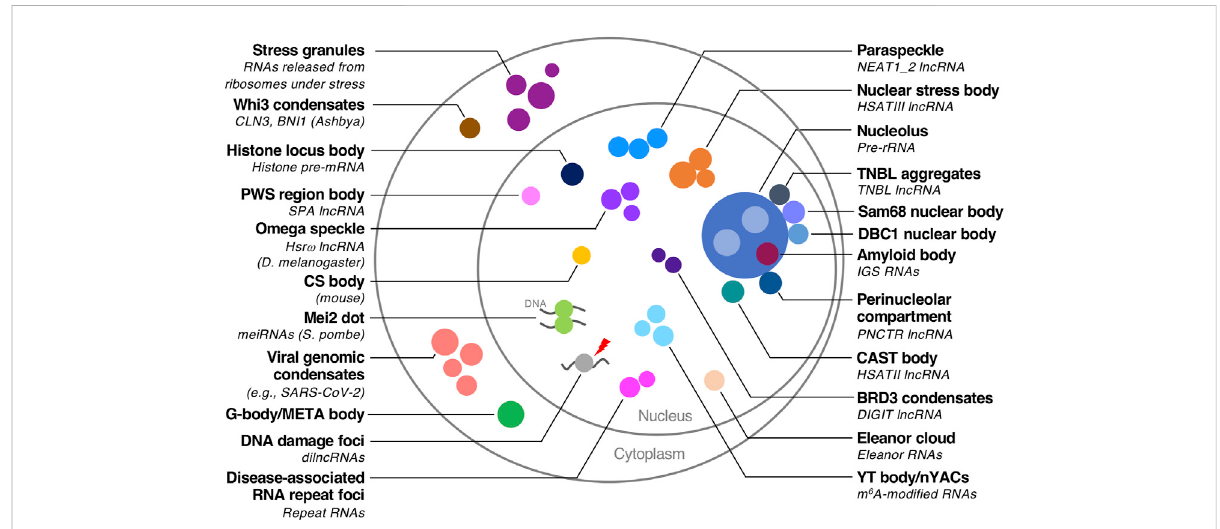
FIGURE 1 Biomolecular condensates with RNA scaffolds. Biomolecular condensates with RNA scaffolds in various organisms are illustrated. The scaffold RNAs are described in parentheses if they are identi fi ed. Species other than humans are also described in